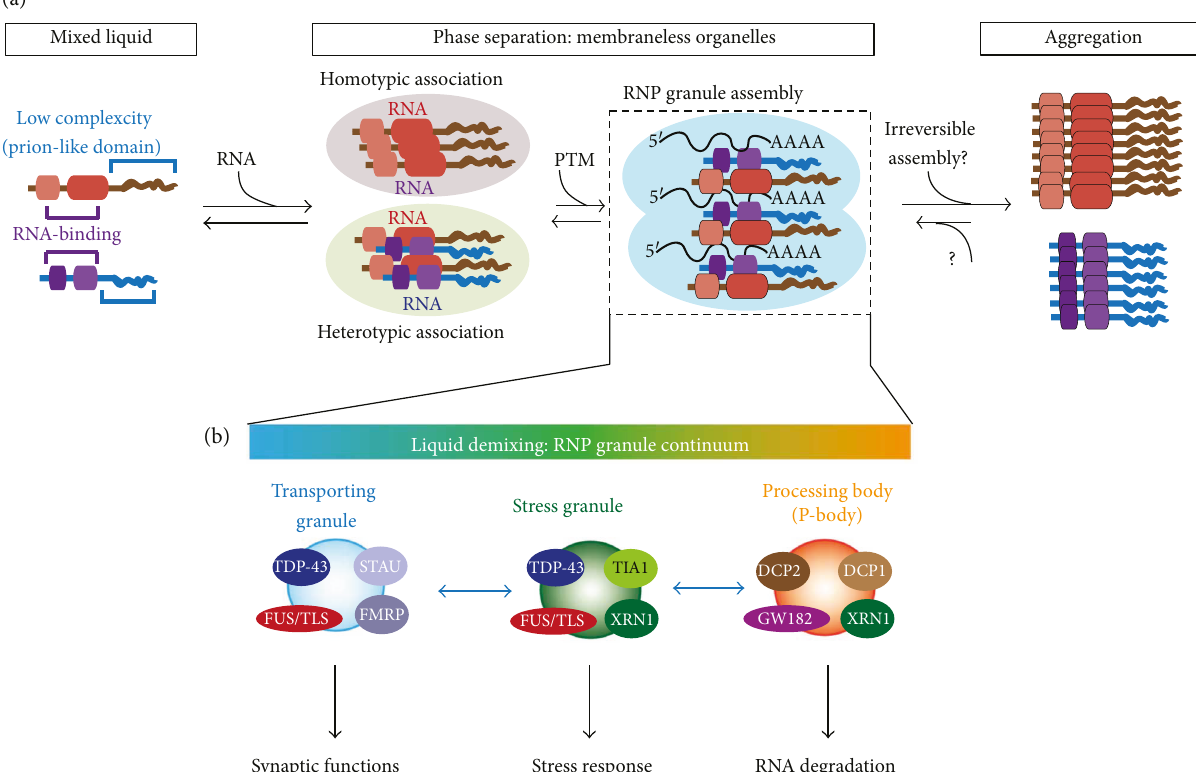
Figure 3: Assembly principle for RNP granules. (a) RNA-binding proteins typically can be separated into RNA-binding domains and low- complexity prion-like domains. Low-complexity domains are intrinsically disordered and can form multivalent weak interactions which nucleate to form phase separation. Posttranslational modi fi cations (PTMs) could aid the occurrence of phase transition. Phase separation generates a phase boundary, such as RNP granules. RNP granules mature into a hydrogel-like state where the molecules have reduced movement. The enrichment of aggregation-prone proteins within the RNP granules may result in the formation of irreversible aggregations observed in neurodegenerative diseases. (b) In neurons, there are three main types of RNA granules: transporting granules, stress granules, and processing body (P-body). Each of them is proposed to perform di ff erent functions. Each type of granule can present stereotypical markers but also share common components. Based on the liquid-liquid demixing, the components can easily transition from one type of granule to another as part of the RNP granule